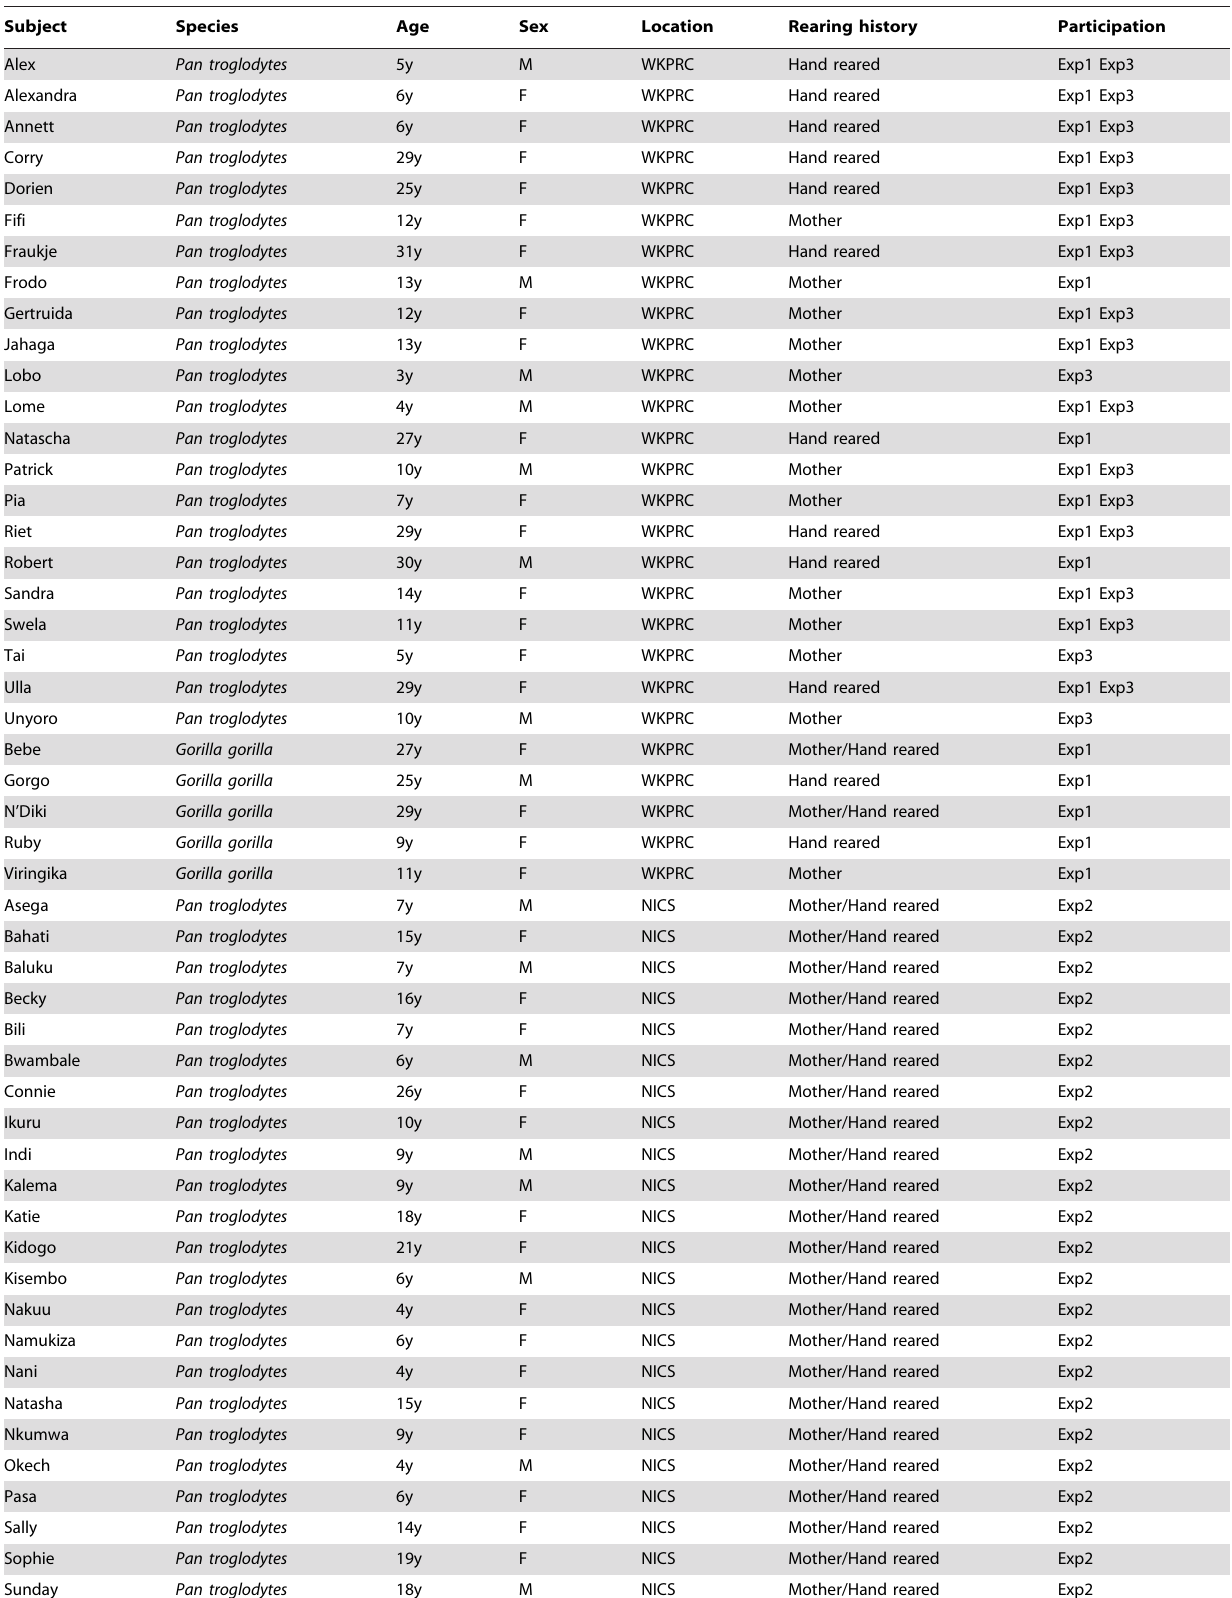
Table 1. Overview of test participation for each ape